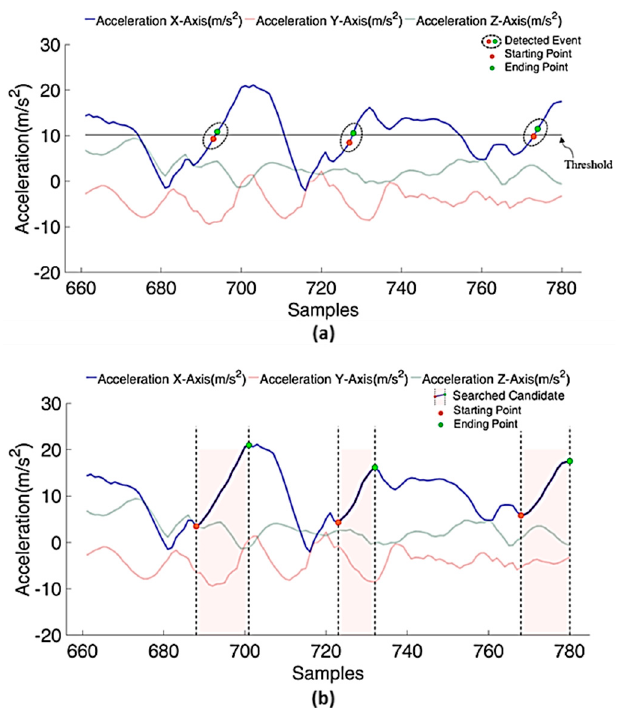
Figure 5. Tri-axial acceleration of a subject performing floor mopping. ( a ) The threshold is determined by the dominant axis (acceleration of the X-axis). Each circle denotes the detected event, which contains starting and ending points, and crossing the threshold in ascending order. ( b ) The covered region by the starting and end points denote the searched candidate for significant change spotting.